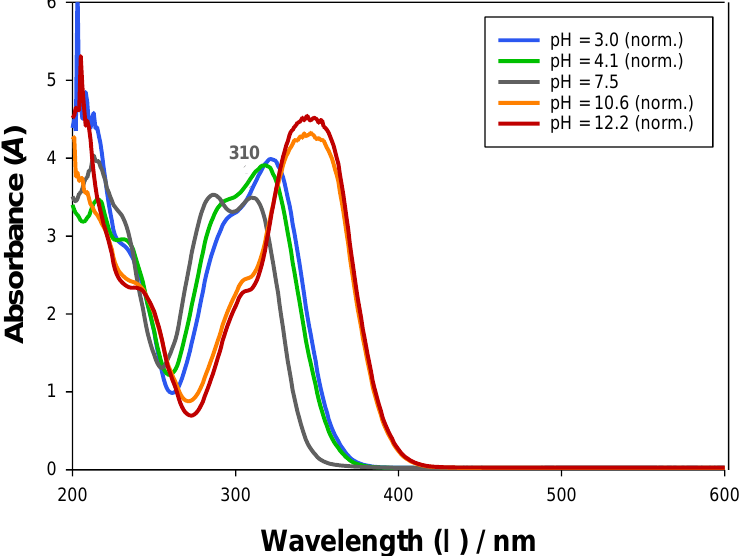
Table 3. Stability of the UV-Vis absorbance spectra of gallic acid (GA) and ferulic acid (FA) after settling for 3 days at 298.15 K and 0.1 MPa.